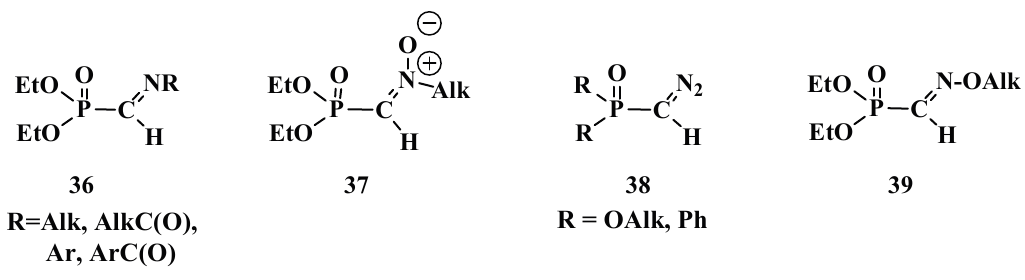
Figure 4. Molecular structures of formylphosphonates of N -substituted imines 36 , N-alkylnitrones 37 , phosphorylated diazomethane 38 and alkylated oximes 39